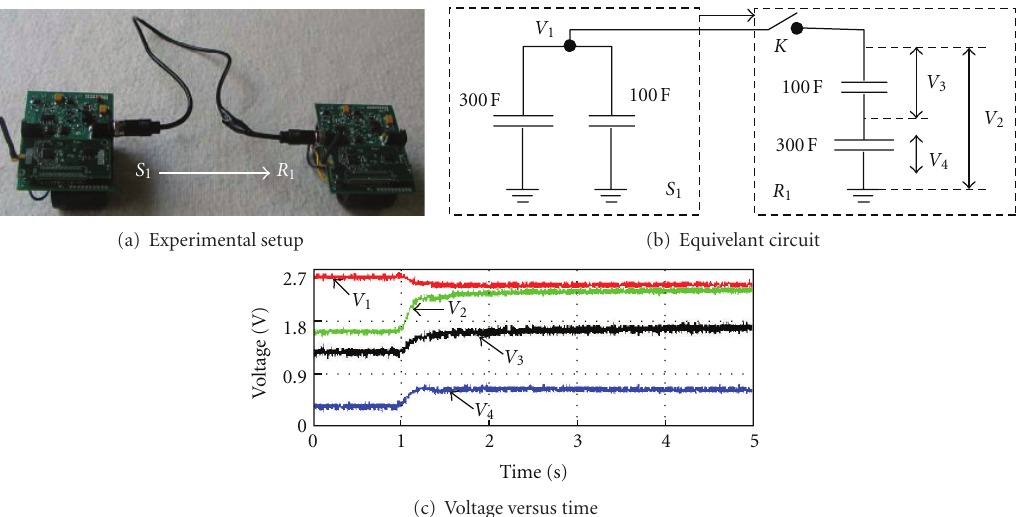
Figure 13: Energy sharing between two devices.